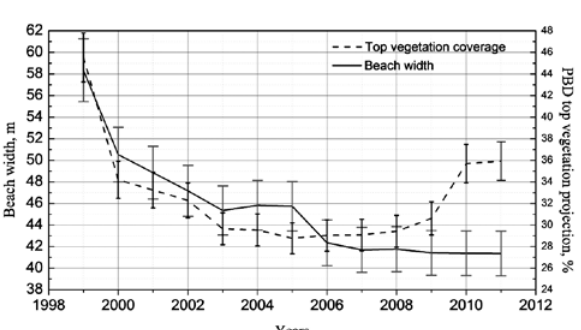
Fig. 3. Changes of beach width and PBD top vegetation